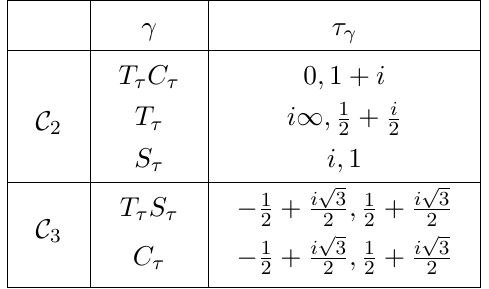
Figure 2 . The fundamental domain D (2) of ¯Γ(2) (i.e., the full target space of Γ 2 ’ S 3 ) with the stabilisers of modular transformations of Γ 2 denoted as dots.